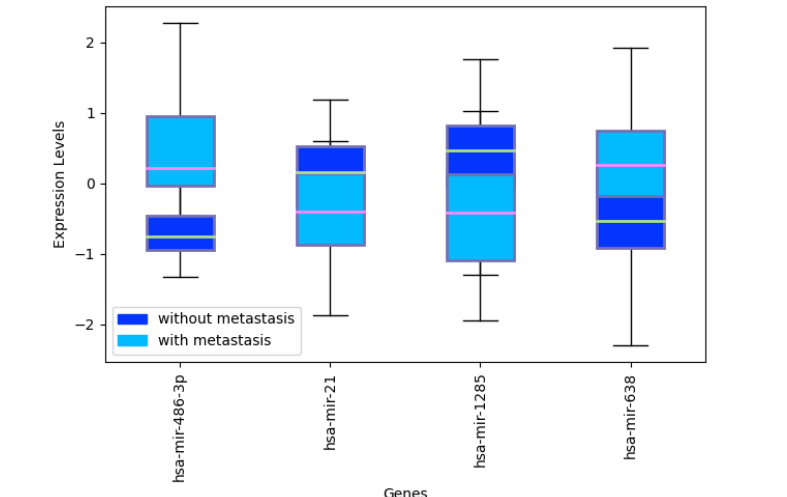
Figure A3. Expression levels of selected miRNAs: hsa-mir-486-3p, hsa-mir-21, hsa-mir-1285, hsa-miR-708 and hsa-mir-638 in CRC samples with and without